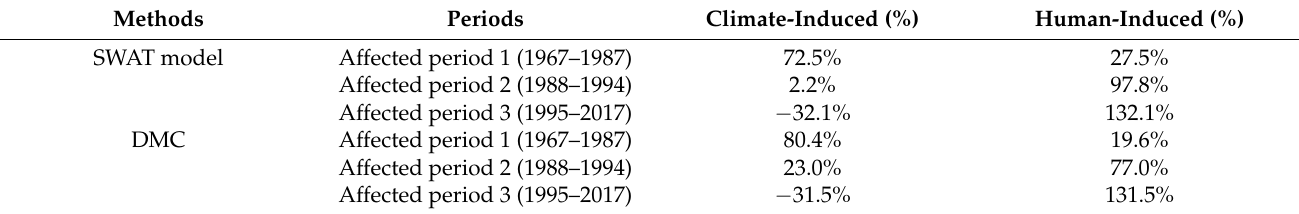
Table 5. Fractional contribution of climate change and human activities (coal mining and soil-water conservation) to runoff decreases in the different periods.